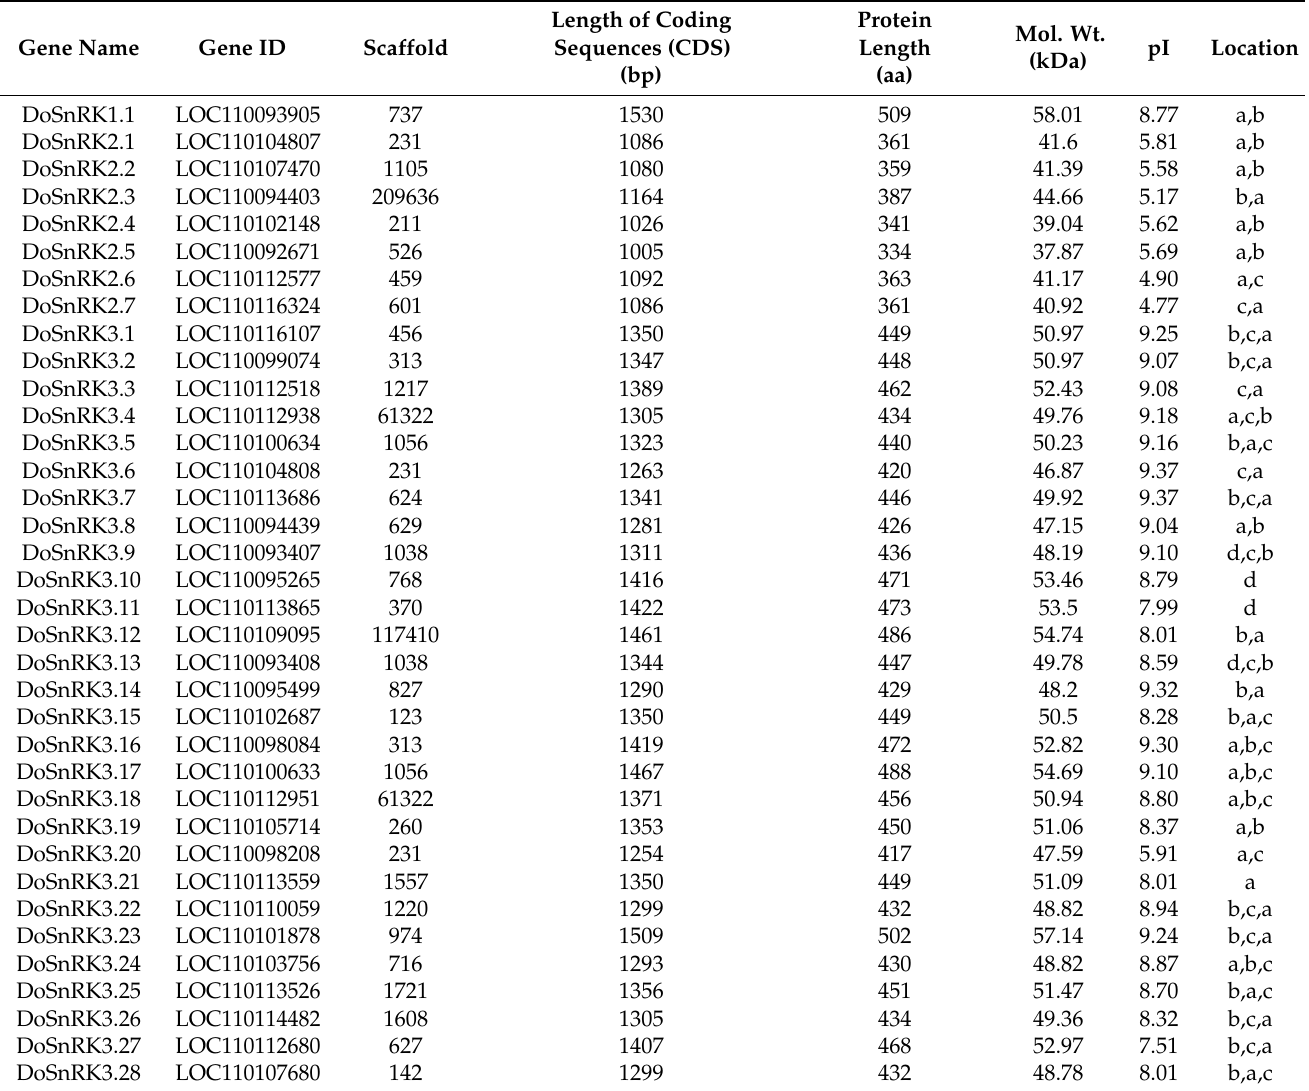
Table 1. The list of 36 DoSnRK genes identified in Dendrobium officinale